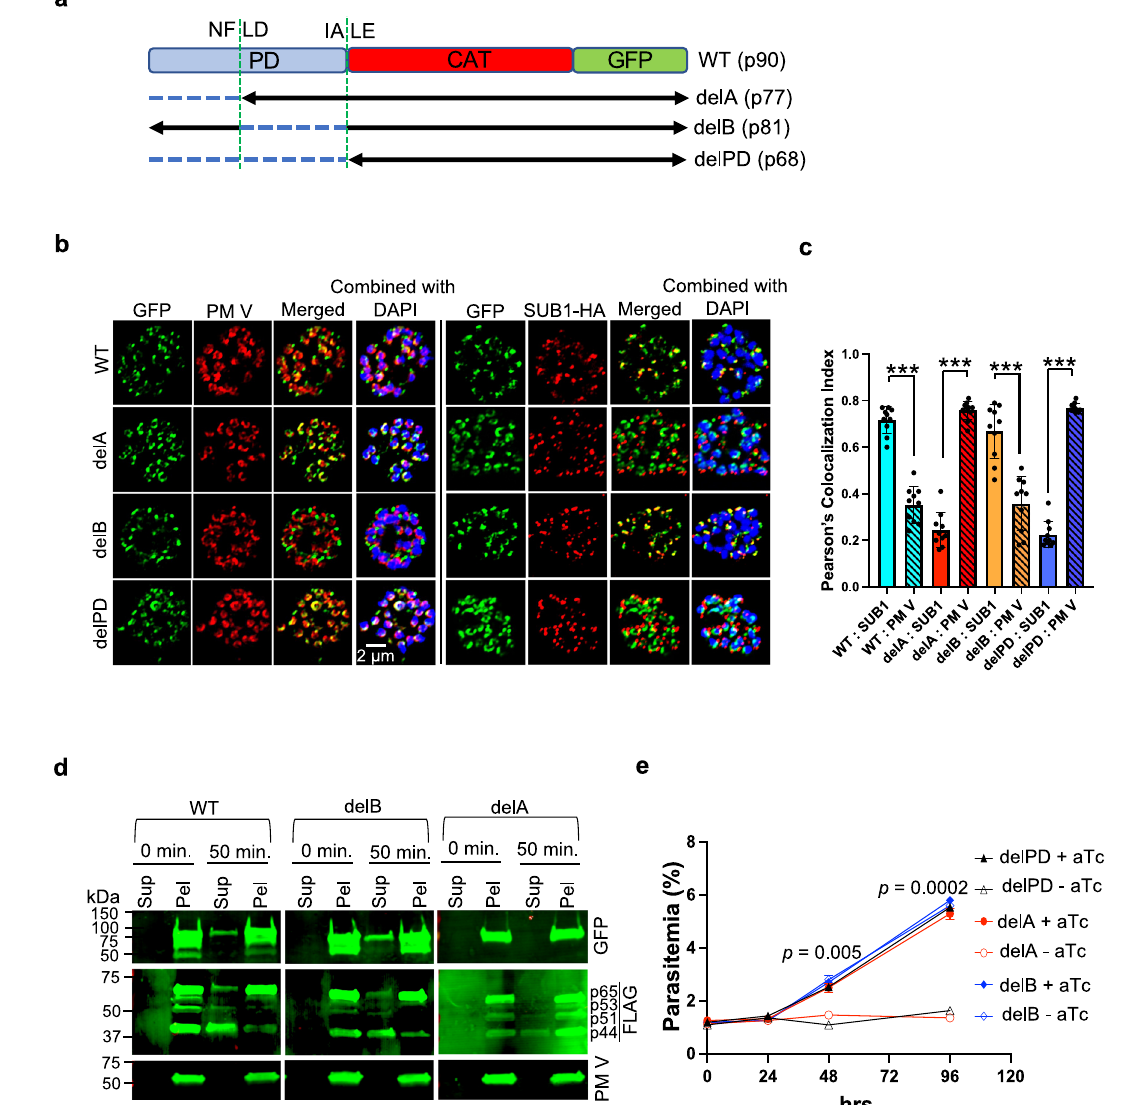
Fig. 5 | The N-terminal half of the prodomain (PD) is critical for intracellular traf fi ckingandfunctionalityofPMX.a SchemeofPDtruncationconstructsthat areC-terminallyGFPtagged andintroducedintothePMX apt lineassecondcopies. b Representative2DconfocalAiryscanimagesshowingcolocalizationbetweenthe second copy PM X and either SUB1-3xHAor PM V. Scale bar: 2 μ m. The 3Dversion of the images are shown in Supplementary Fig. 7. c Quanti fi cation from Supple- mentary Fig. 7. Experiments were repeated two times, and for each line 10 schi- zonts were analyzed. Mean values are shown. Error bars represent standard deviation. *** p <0.001. For exact p values refer to the source fi le. d Zaprinast- induced discharge of second copy WT and delB but not delA mutant PM X from